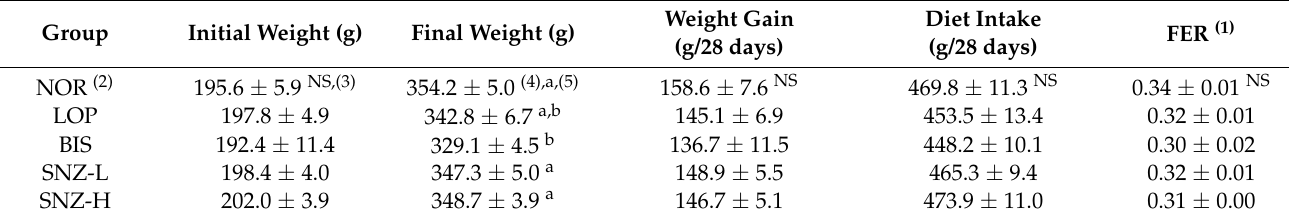
Table 2. Initial and final body weight, total dietary intakes, and food efficiency ratio (FER).